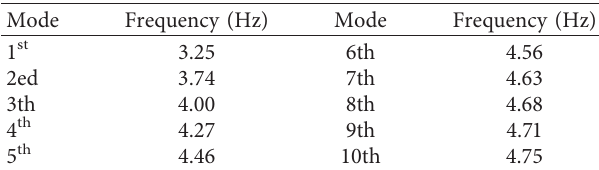
Table 2: The first 10 modes of natural